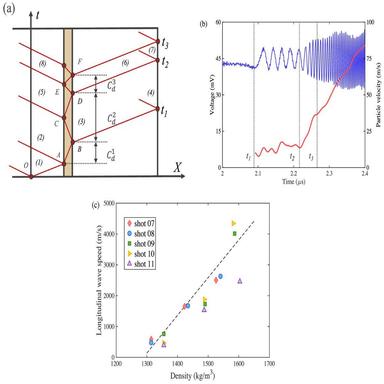
Average longitudinal wave speed analysis of granular boron carbide: (a) Lagrange wave schematic of the first six wave reverberations through the material assuming the linear waves; (b) corresponding NDI fringes and velocity history with wave arrival time being labeled. The blue curve is the NDI signal and the red curve is the normal particle velocity; (c) The evolution of estimated average longitudinal wave speed with respect to the density. (For interpretation of the references to color in this figure lege